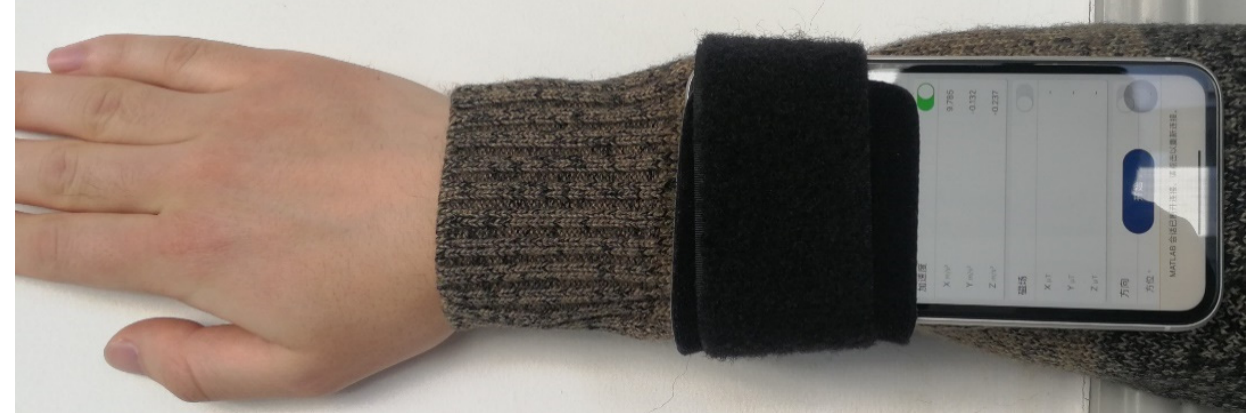
Figure 11. The smartphone attached to the volunteer’s arm.